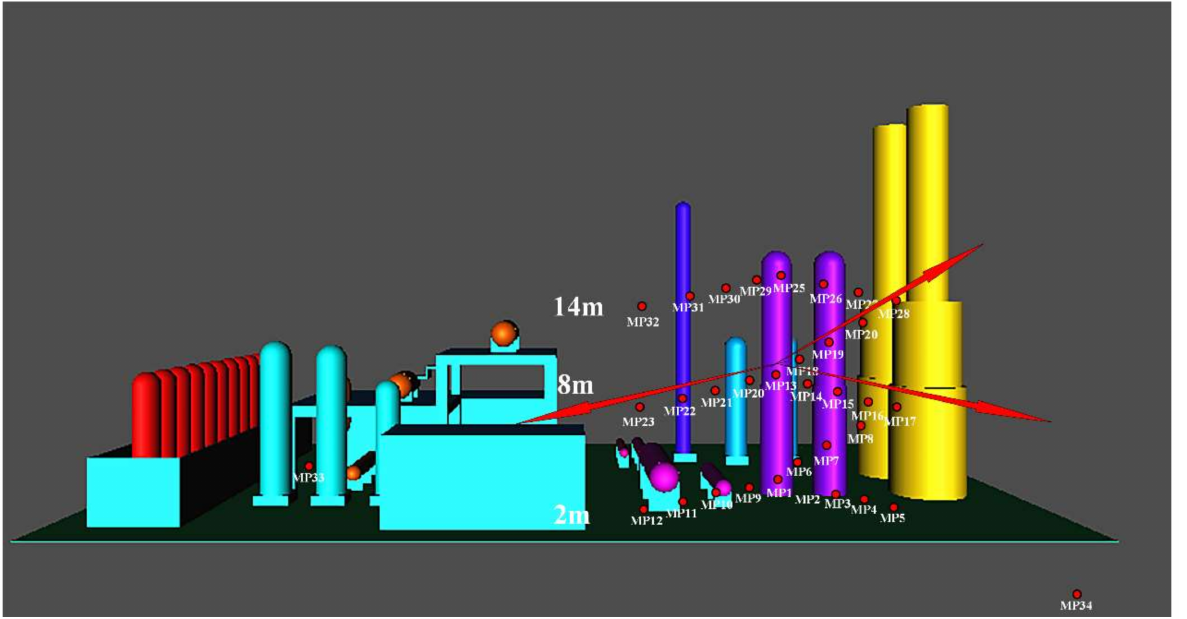
Figure 2. Distribution of monitoring points of gas volume ratio concentration. Those red dots represented monitoring points are distributed at the height of 2 m, 8 m, and 14 m, which can discover the gas leak in different parts of the equipment. Each of them is at an interval of 3 m. Two monitors named MP 33 and MP 34 are placed far away from the leak point with 50 m over the ground of 1